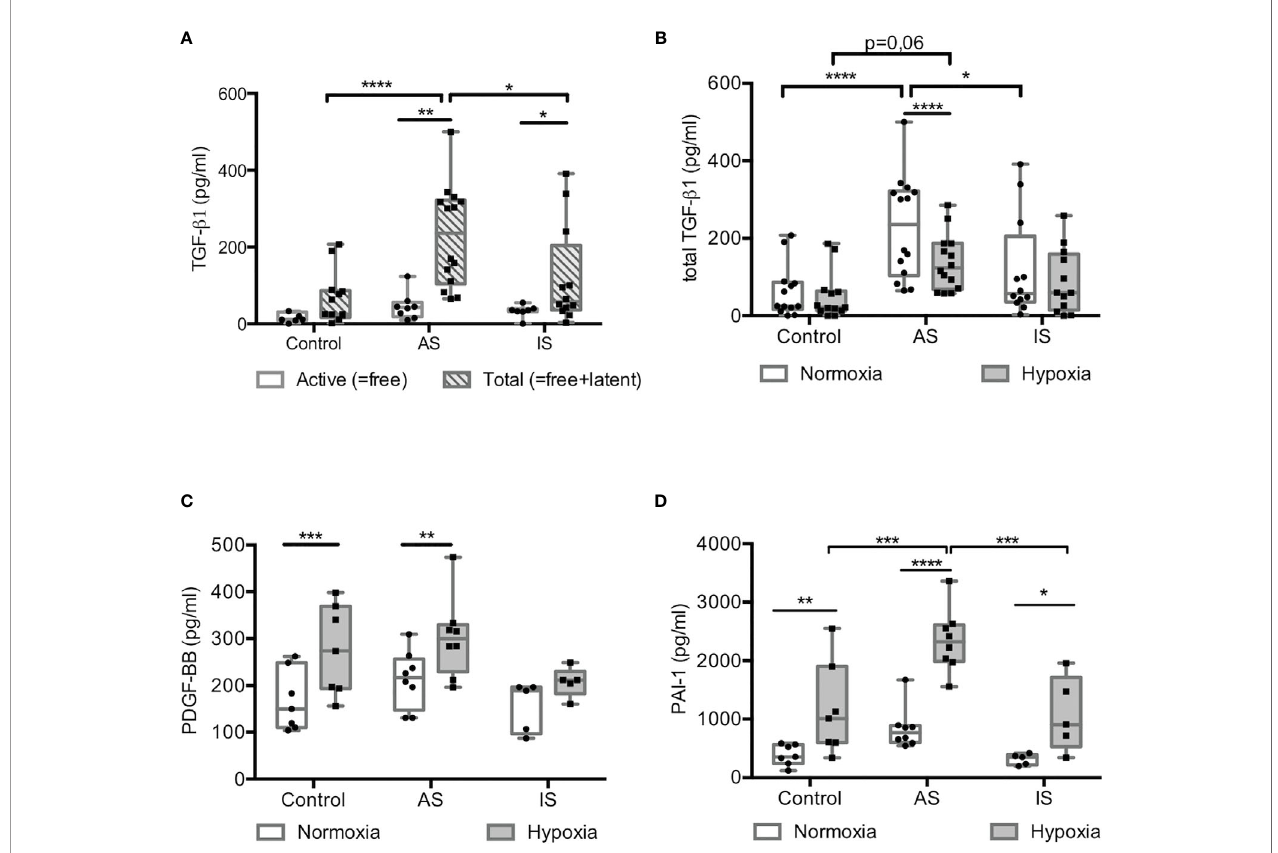
FIGURE 5 | Hypoxia promoted a pro fi brotic response in high active sarcoidosis. (A) Active (free) and total (free+latent) TGß1 (in pg/ml) measured by ELISA in conditioned media from MD-macrophages after 24hrs of normoxia. (n= 7-14 independent experiments). (B – D) Concentrations of total TGFß1 (B) , PDGF-BB (C) and PAI-1 (D) assessed by Luminex ® in conditioned media of normoxic and hypoxic MD-macrophages from controls, high active sarcoidosis (AS), and low active or inactive sarcoidosis (IS). Each point indicates a patient and/or control (n= 5-8/group). Results are expressed in pg/ml with box plot showing 25 th and 75 th percentile and median. *p < 0.05; **p < 0.01; ***p < 0.001; ****p < 0.0001 in two-way ANOVA-repeated measures and two-way ANOVA with Sidak post-hoc